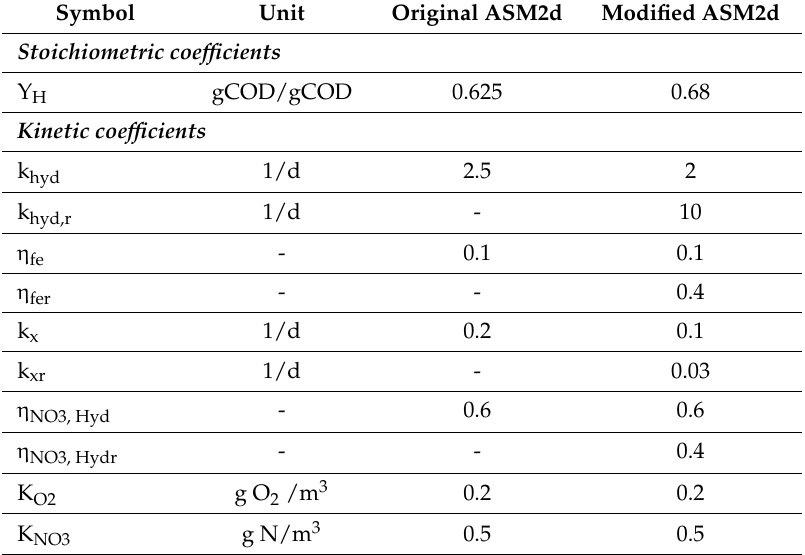
Table 2. Comparison of the calibration values at the original and the modified ASM2d.